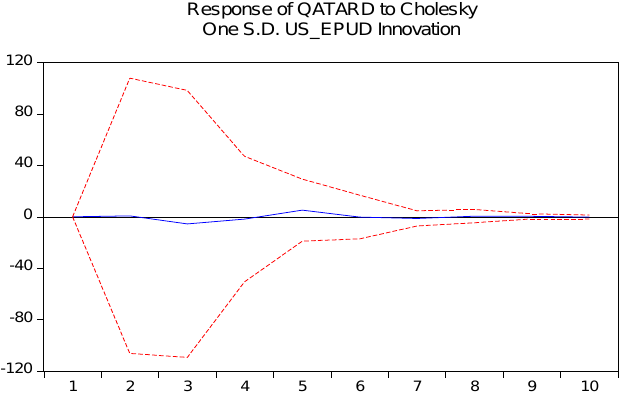
Fig. 4. The impulse response functions of the returns on Qatar stock market to changes in the U.S. economic policy uncertainty (2004:M7 –